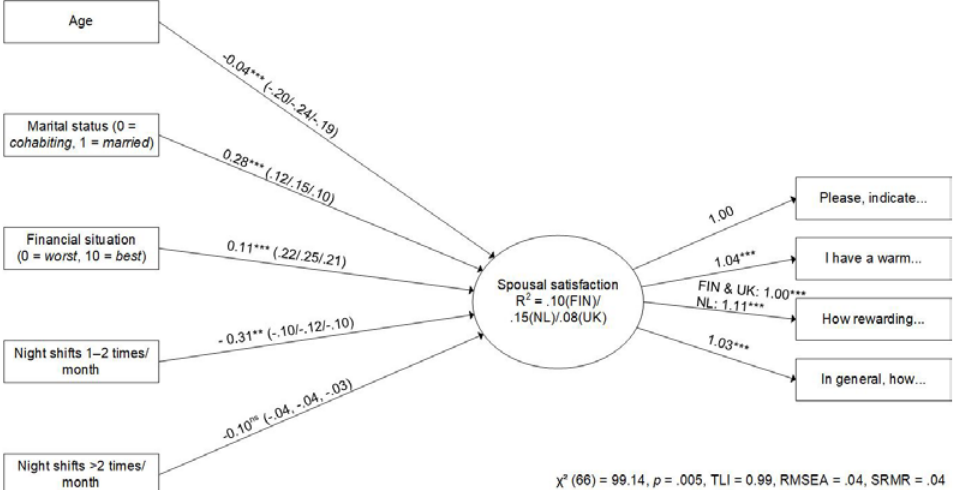
Figure 1 : Multigroup SEM model explaining spousal satisfaction, unstandardized coeffi- cients (standardized coefficients for Finland/the Netherlands/and the United Kingdom in